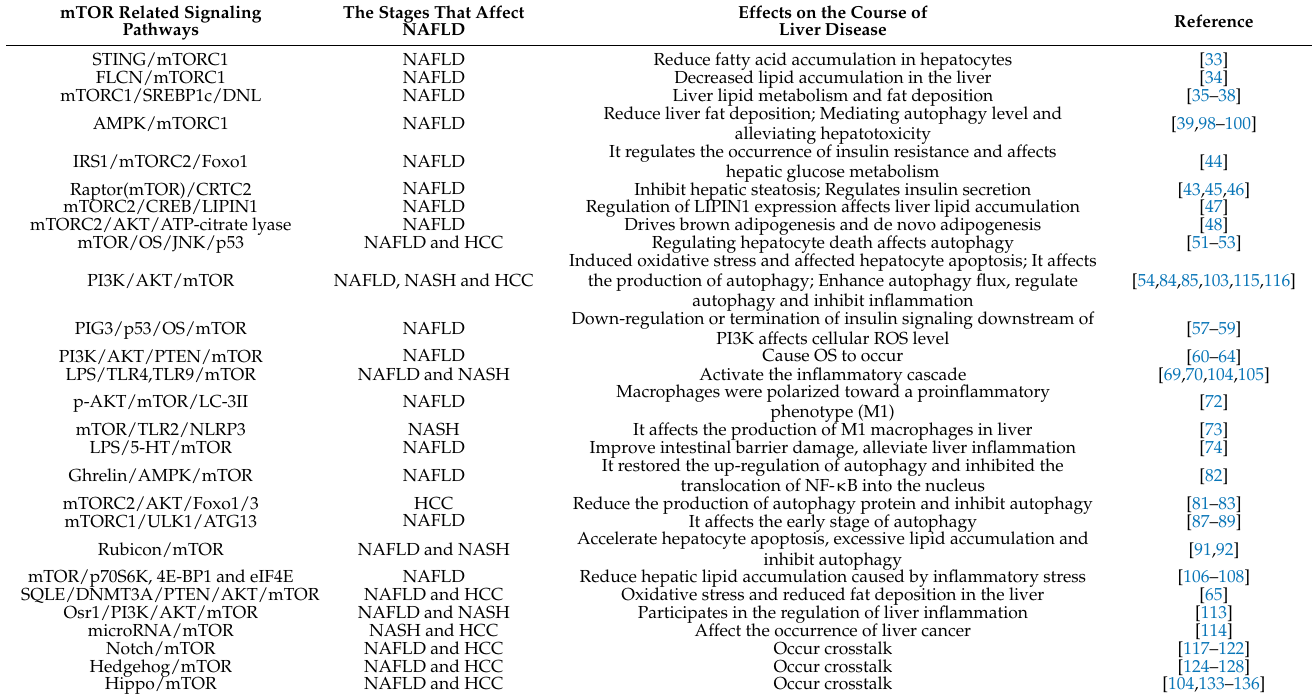
Table 1. Summary Table of mTOR-related signaling pathways affecting the various stages of